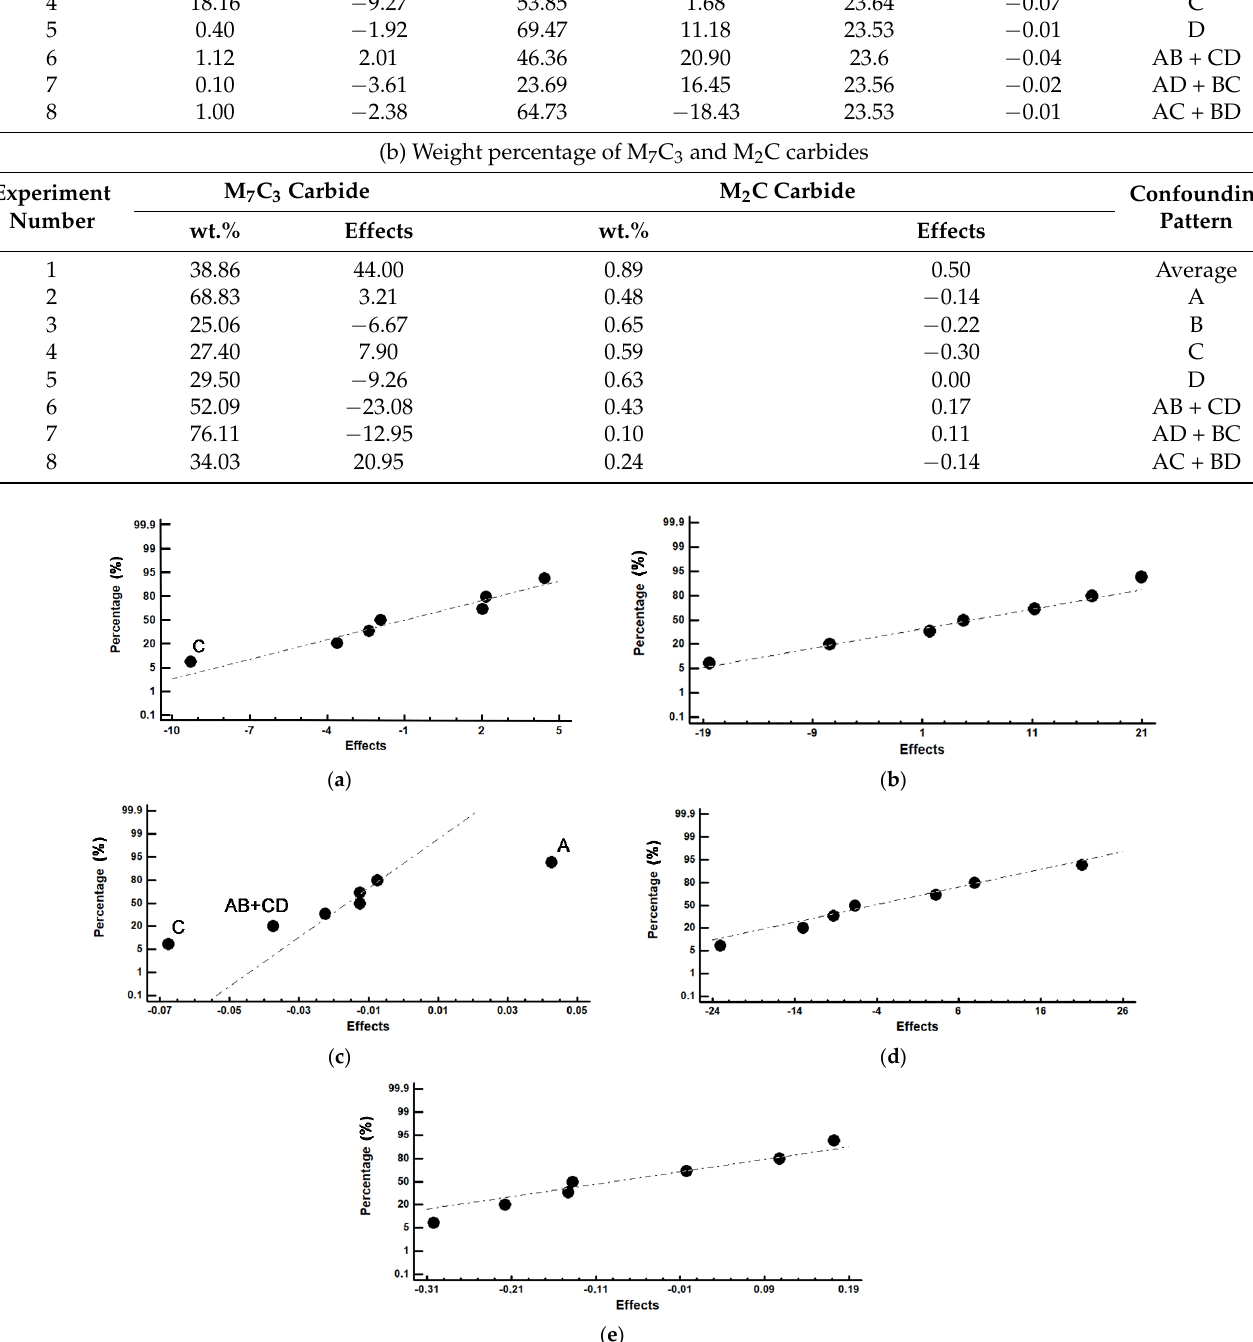
Figure 2. Representation of the standardized effects for the weight percentages of the different phases plotted on a normal probability graph. Factors with a significant effect have been labelled. A (destabilisation temperature); B (cooling media); C (tempering temperature); D (tempering time): ( a ) wt.% austenite; ( b ) wt.% tempered martensite; ( c ) cell volume of tempered martensite; ( d ) wt.% carbides M 7 C 3 (K 2 ); ( e ) wt.% carbides M 2 C.